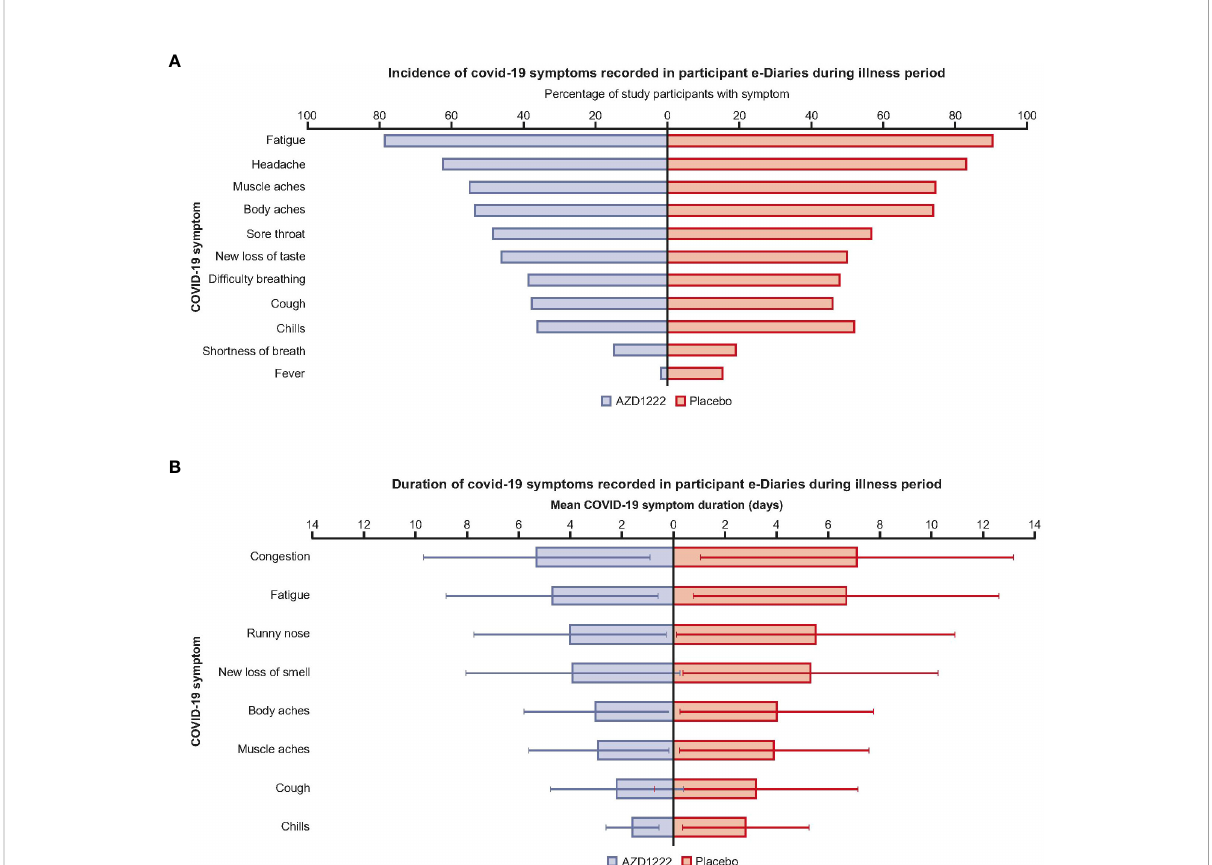
FIGURE 1 AZD1222 vaccinees had an overall lower incidence and shorter duration of COVID-19 symptoms compared with placebo recipients upon symptomatic SARS-CoV-2 infection. (A) Incidence and (B) mean duration of self-reported COVID-19 symptoms recorded in participant e- Diaries during the 28-day illness period. (A) Symptoms with differences of ≤ 1.5% between arms were excluded from this plot. (B) Symptoms with differences in mean durations of ≤ 1 day between arms are excluded from this plot. Error bars depict standard